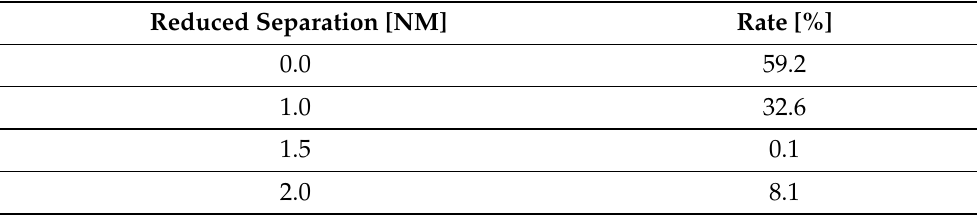
Table 9. Rate of aircraft pairs for which separation minima were reduced by applying RECAT at runway 34L.